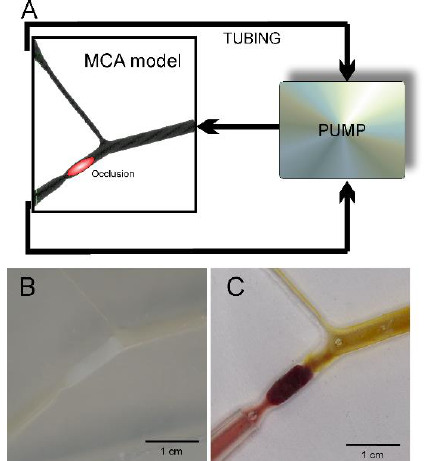
Figure 3. Complete occlusion of in vitro middle cerebral artery. ( A ) Schematic representation of the whole system composed of the pump, tubing, and the MCA model. Part of the MCA model with occlusion induced by fibrin clot prepared from the TISSEEL kit ( B ) and whole blood clot ( C ). Yellow fluorescein-colored plasma in incoming parts of the MCA and red blood cell-colored fluid behind the clot confirmed complete occlusion of the arteria lumen ( C ).